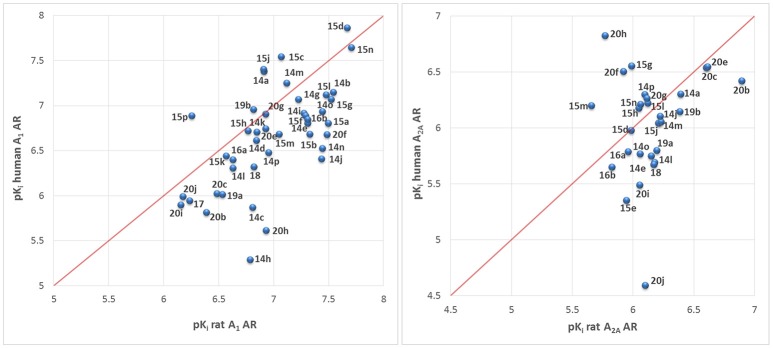
Correlation of affinities at human vs. rat A1 and A2A ARs.